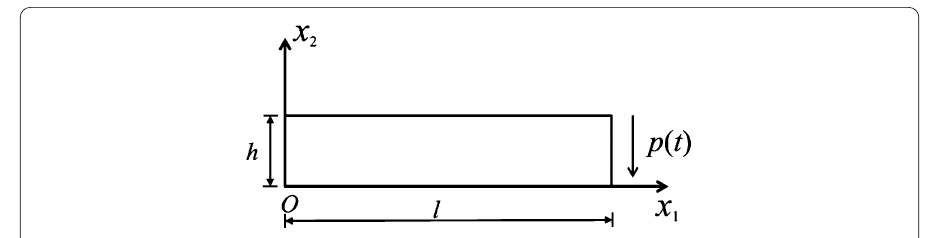
Figure 3 The dynamic load